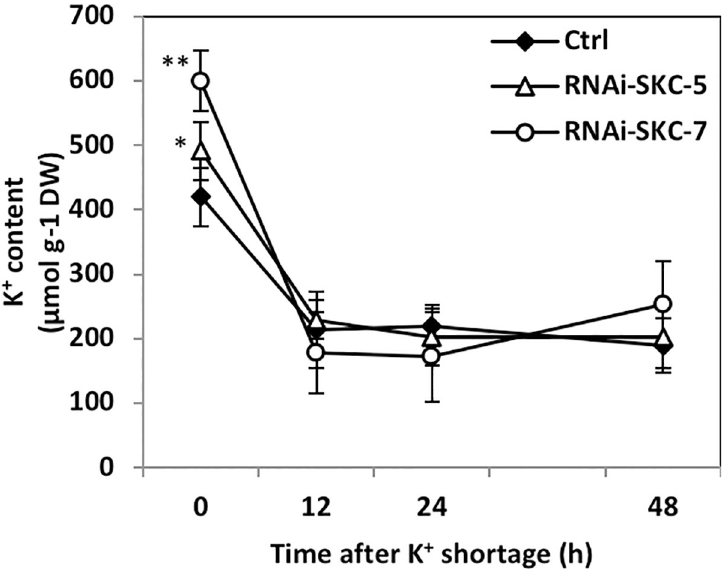
Fig 4. Potassium content in Hebeloma cylindrosporum HcSKC downregulated lines. K + content was measured in fungal lines transformed with the empty (Ctrl) or HcSKC -silencing vectors (RNAi-SKC-5 and RNAi-SKC-7) using an atomic absorption flame spectrophotometer. Statistical differences were evaluated using the Student’s test with respect to the Ctrl strain ( � , P < 0.05; �� , P < 0.01). n = 6.